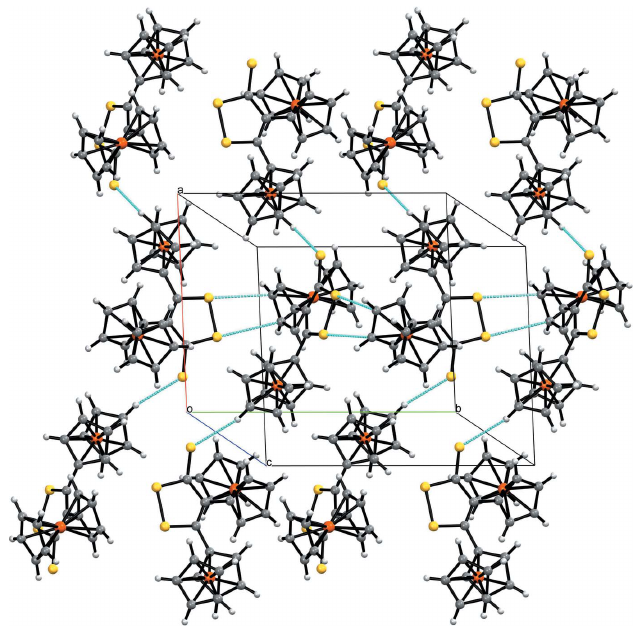
Figure 2 The crystal structure of the title compound along the base vector [010], showing the intermolecular contacts of the S (cid:2)(cid:2)(cid:2) (cid:2) (C—C) type as dotted turquoise lines.